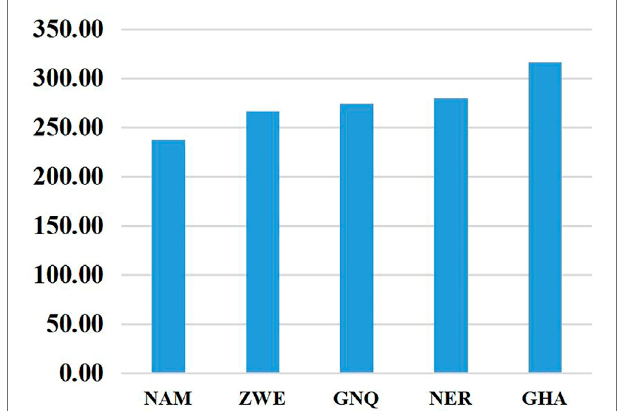
FIGURE 2 | Lowest (inef fi cient). country-speci fi c business environment in SSA. note: TCD, Chad; SEN, Senegal; BDI, Burundi; BFA, Burkina Faso; BWA, Botswana; NAM, Namibia; ZWE, Zimbabwe; GNQ, Equatorial Guinea; NER, Niger; GHA, Ghana. Trends are measures on averages of the six indicators of TF [costs, documents, and time (to import and export)]. Source: Author ’ s computation with data from World Bank WDI